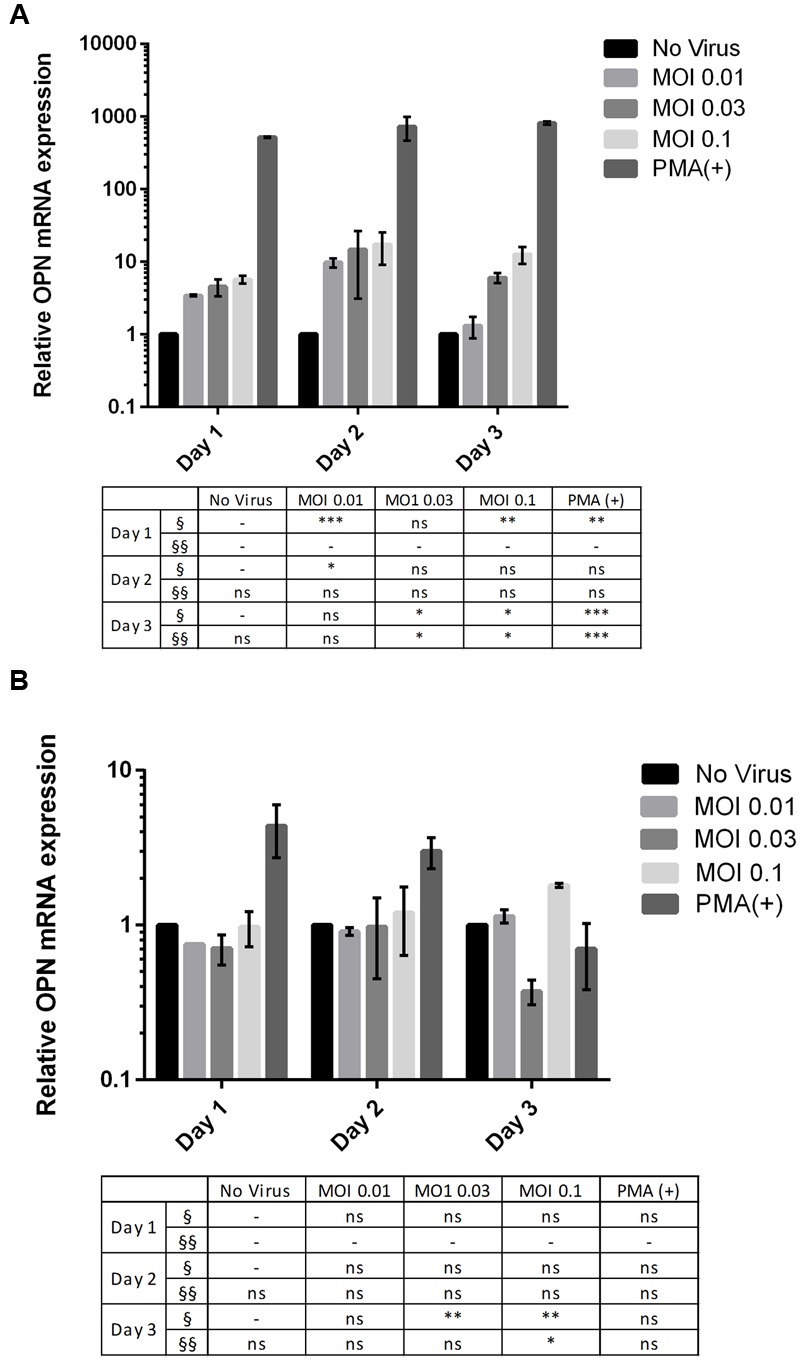
Multiplicity of infection (MOI)- and time-dependent change in OPN mRNA expression upon dengue virus (DENV) infection. (A) THP-1 and (B) 293T cells were infected with DENV-3 at various MOIs (range: 0.01–0.1). Phorbol 12-myristate 13-acetate (PMA) was used as a positive control. Cells were harvested daily (1–3 days). Total RNA was prepared from cell lysates and OPN levels were determined by RT-qPCR. GAPDH was used as reference gene to normalize the expression level. The table summarizes statistical analysis, ∗P < 0.05, ∗∗P < 0.01, ∗∗∗P < 0.001 vs. control (uninfected cells; unpaired two-tailed t-test). Data represent mean ± SEM. § and §§ represent MOI- and time-dependent variables, respectively.